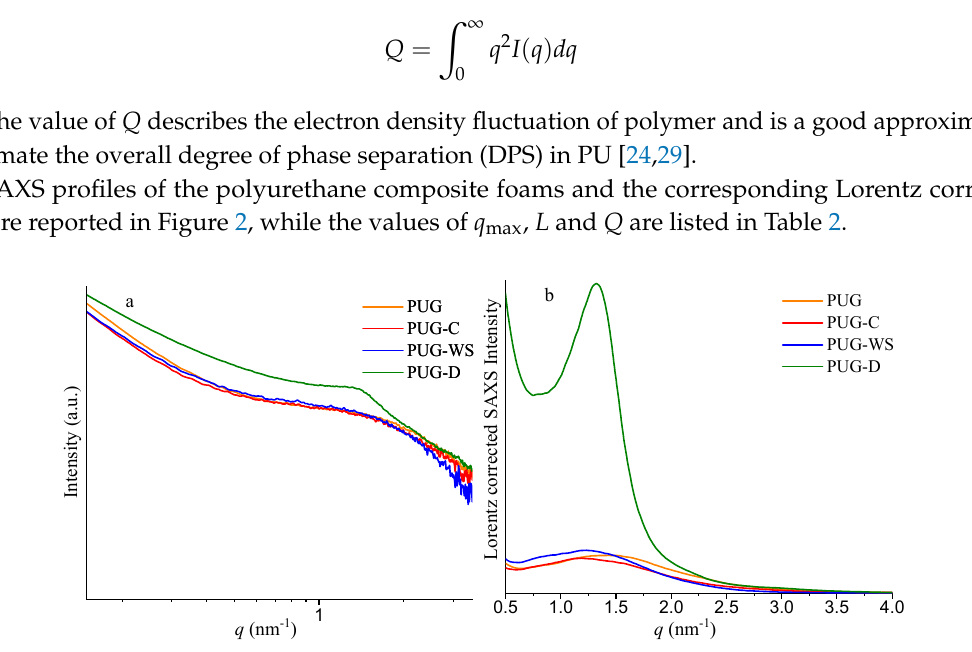
Figure 2. Small angle X-ray scattering (SAXS) profiles ( a ) and corresponding Lorentz corrected plots ( b ) of the polyurethane composite foams PUG, PUG-C, PUG-WS and PUG-D. Table 2. Values of the q max (nm − 1 ), L (nm), and Q for the polyurethane composite foams PUG, PUG- C, PUG-WS and PUG-D.